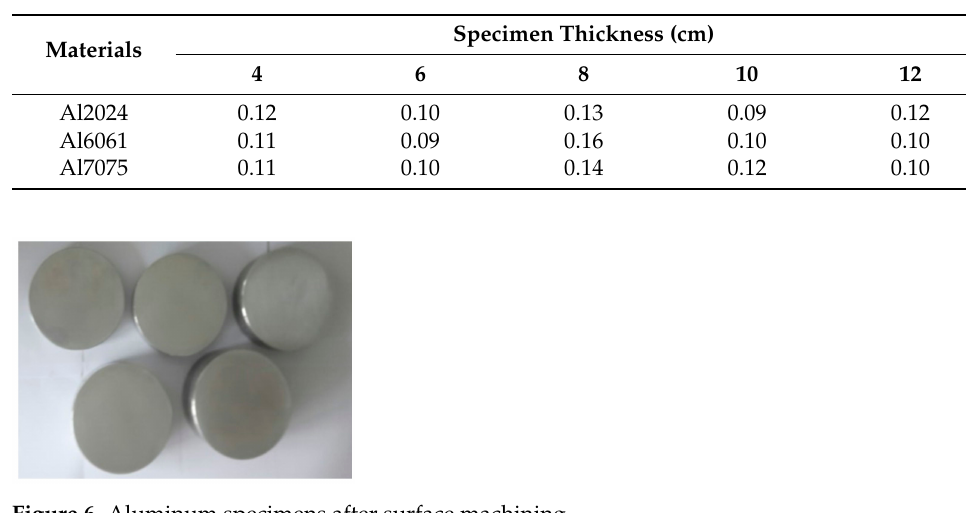
Table 2. Surface roughness of aluminum specimens (Unit: µ m).